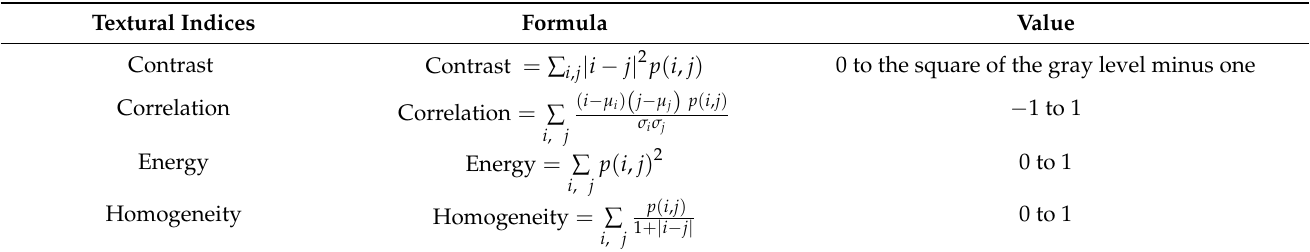
Table 3. The definition of the textural indices used in this study. The first column indicates the name of textural indices, the second column is the corresponding definition, and the third column is the ranges of each textural